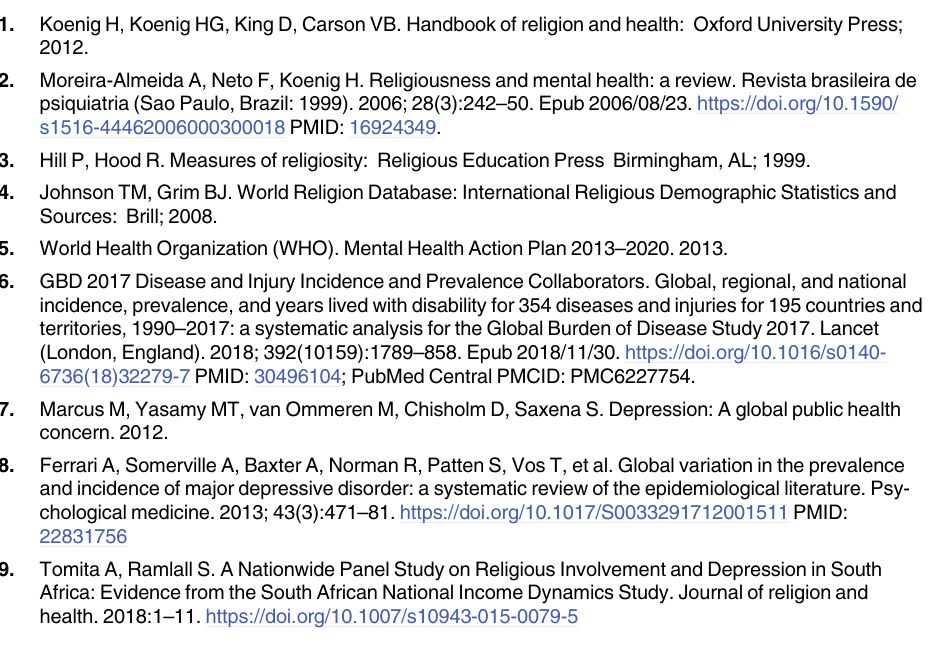
S1 Table. Minidataset. Database and